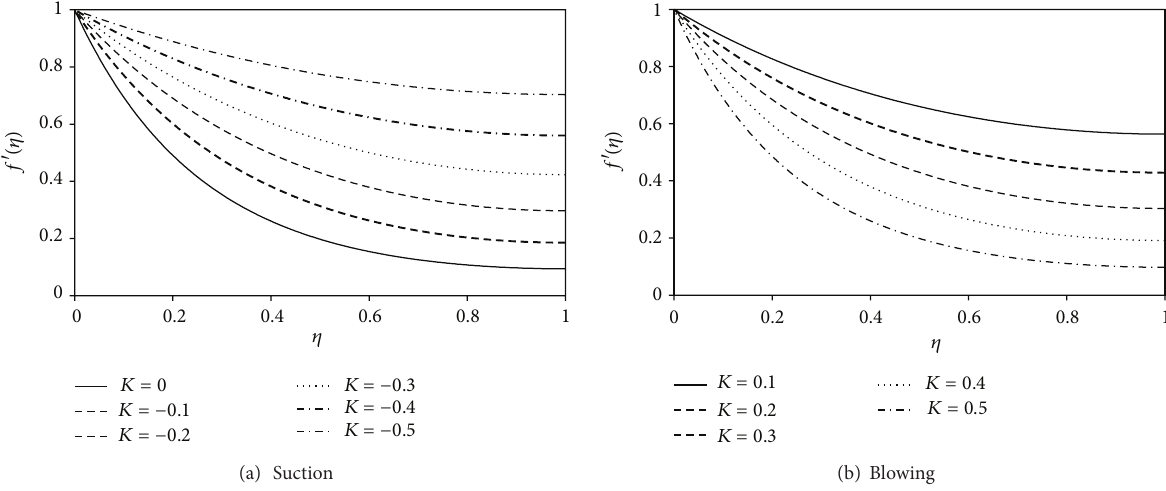
Figure 4: The effect of permeability parameter 𝐾 on the velocity distributions 𝑓 󸀠 (𝜂) using 10th-order HAM approximation when Pr = 1